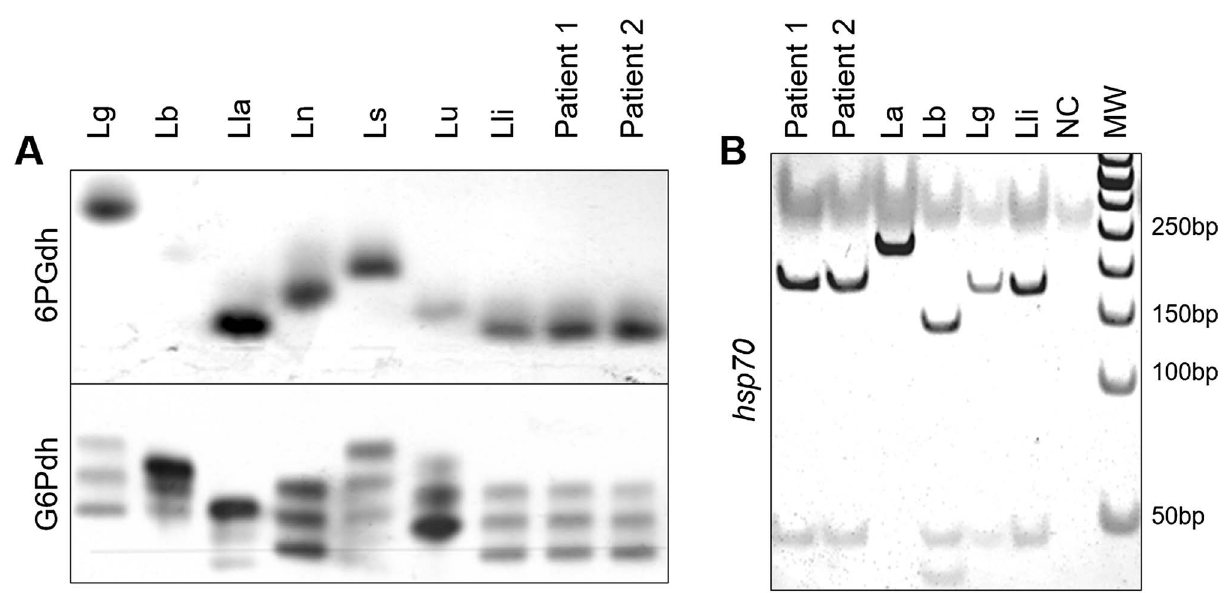
Figure 3. Multilocus Enzyme Electrophoresis (MLEE) and hsp70 PCR-RFLP for Leishmania species identi fi cation. (A) Agarose gels stained for activity of 6-phosphogluconate dehydrogenase (6PGD) and glucose-6-phosphate dehydrogenase (G6PD) showing the patterns for Leishmania parasites isolated from Patients 1 and 2. (B) Polyacrylamide gel showing hsp 70 products digested with HaeI II for Leishmania parasites isolated from Patients 1 and 2. In both assays, the pro fi les obtained for the two samples were compared to reference strains from different Leishmania species. For MLEE, the pattern was compatible with Leishmania ( Viannia ) lindenbergi . hsp70 PCR-RFLP was not useful for species identi fi cation of parasites from the two patients studied, as this marker cannot distinguish between L . ( V .) lindenbergi and L . ( V .) guyanensis . Lg = L . guyanensis , Lb = L . braziliensis , Lla = L . lainsoni , Ln = L . naif fi , Ls = L . shawi , Lu = L . utingensis , Lli = L . lindenbergi , and La = L . amazonensis ; NC = Negative Control; MW = Molecular Weight